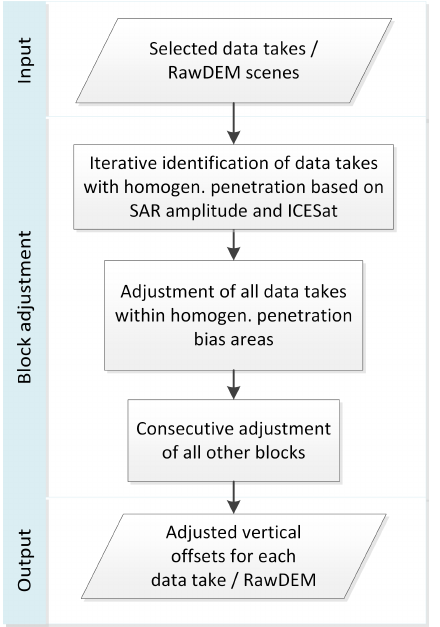
Figure 3. Workflow for DEM adjustment of TanDEM-X DEM data takes in